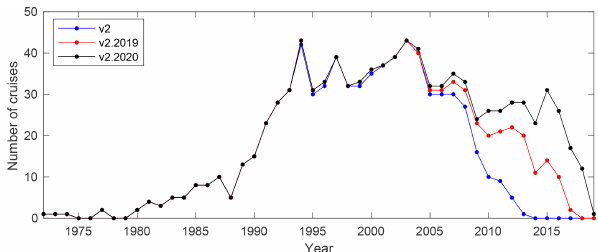
Figure 2. Number of cruises per year in GLODAPv2, GLO- DAPv2.2019, and